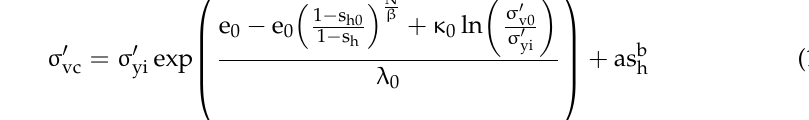
Figure 4. The distribution of pore pressure for constant well pressure.